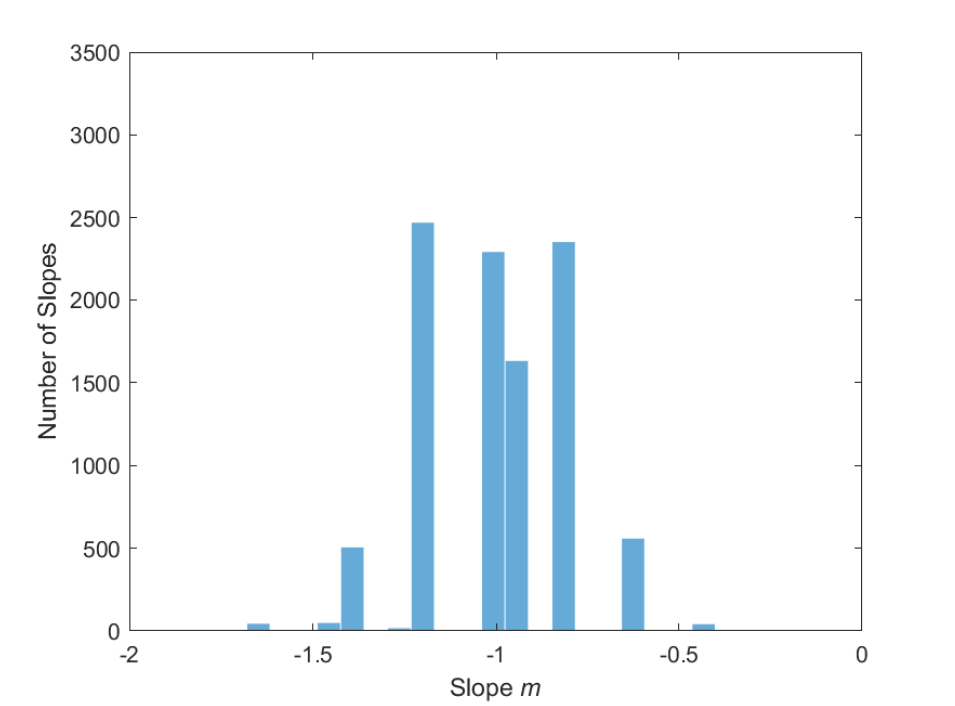
Figure 15. As in Figure 14, but the slopes of the 50 “galaxy” samples were chosen randomly from the interval ( − 1.6, − 0.4). The slopes m of the 10,000 log N -log F max diagrams do not aggregate at m = −